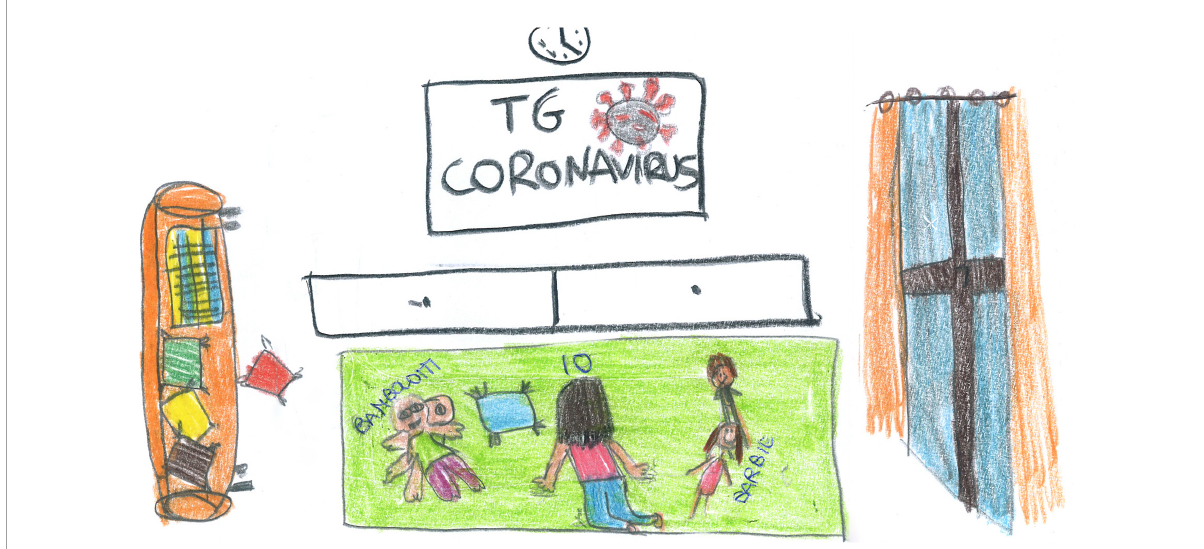
FIGURE14 Playing at home. The TV screen is showing the pandemic news, but the children are playing inside a separate area, marked by the green carpet, that seems to keep them safe from the menacing world (PS, Female, 10